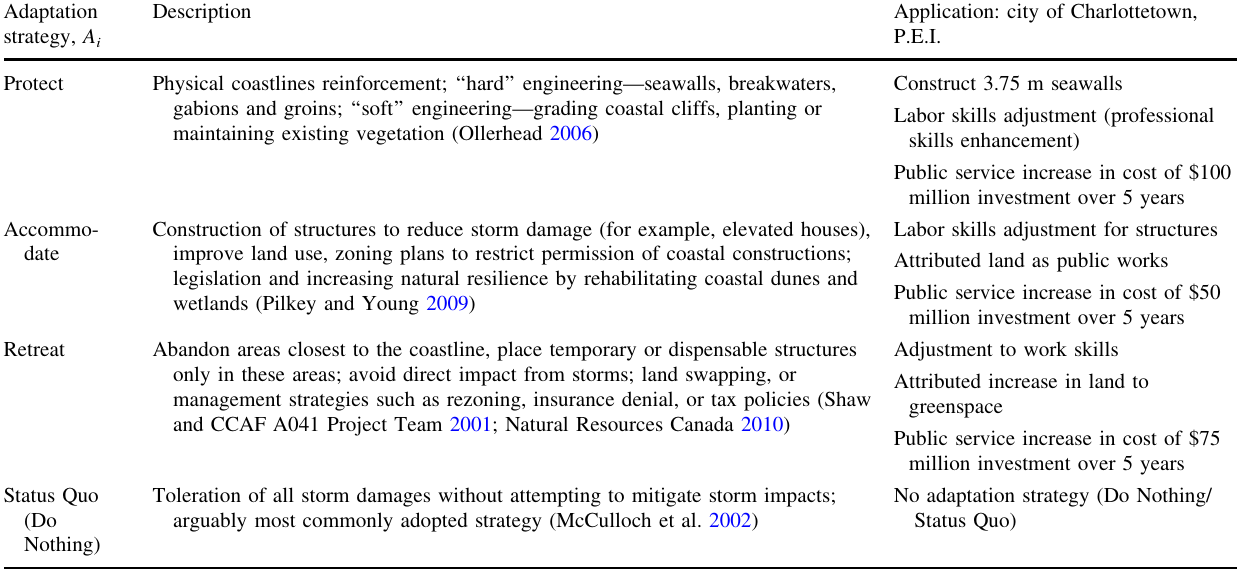
Table 6 System dynamics model controllable variables—Charlottetown, Prince Edward Island, adaptation strategies, A i Adaptation strategy, A i